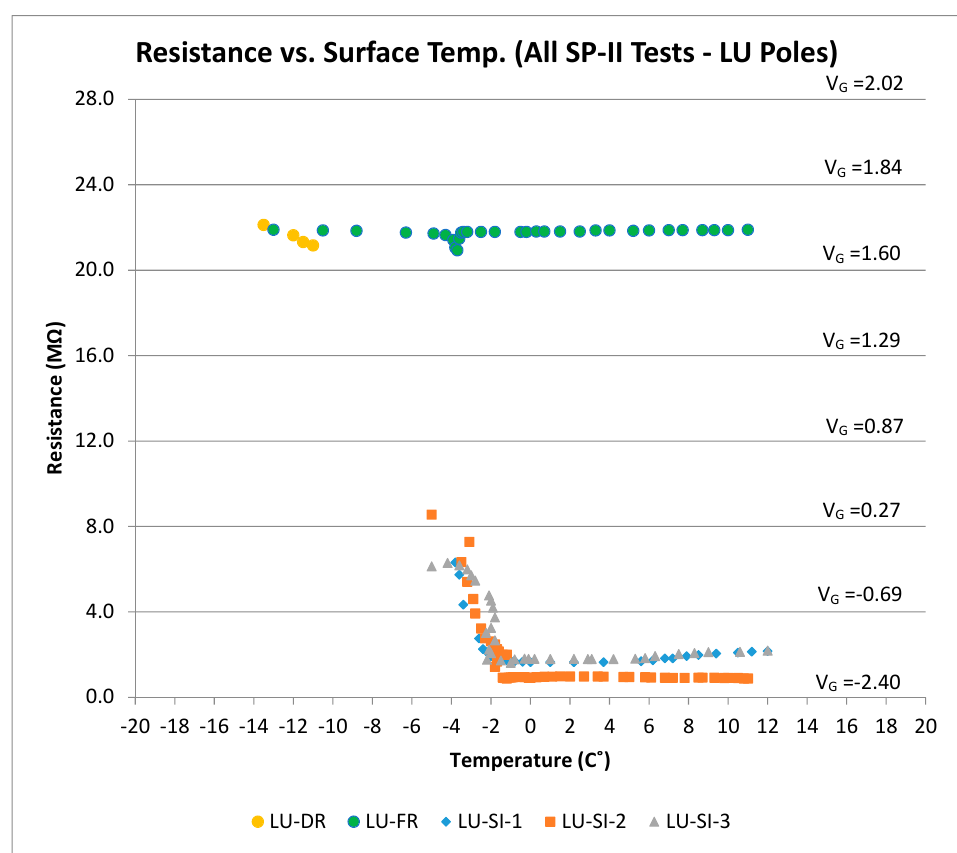
Figure 16. Resistance (and voltage) versus surface temperature for all SP-II prototype tests (LU Poles).